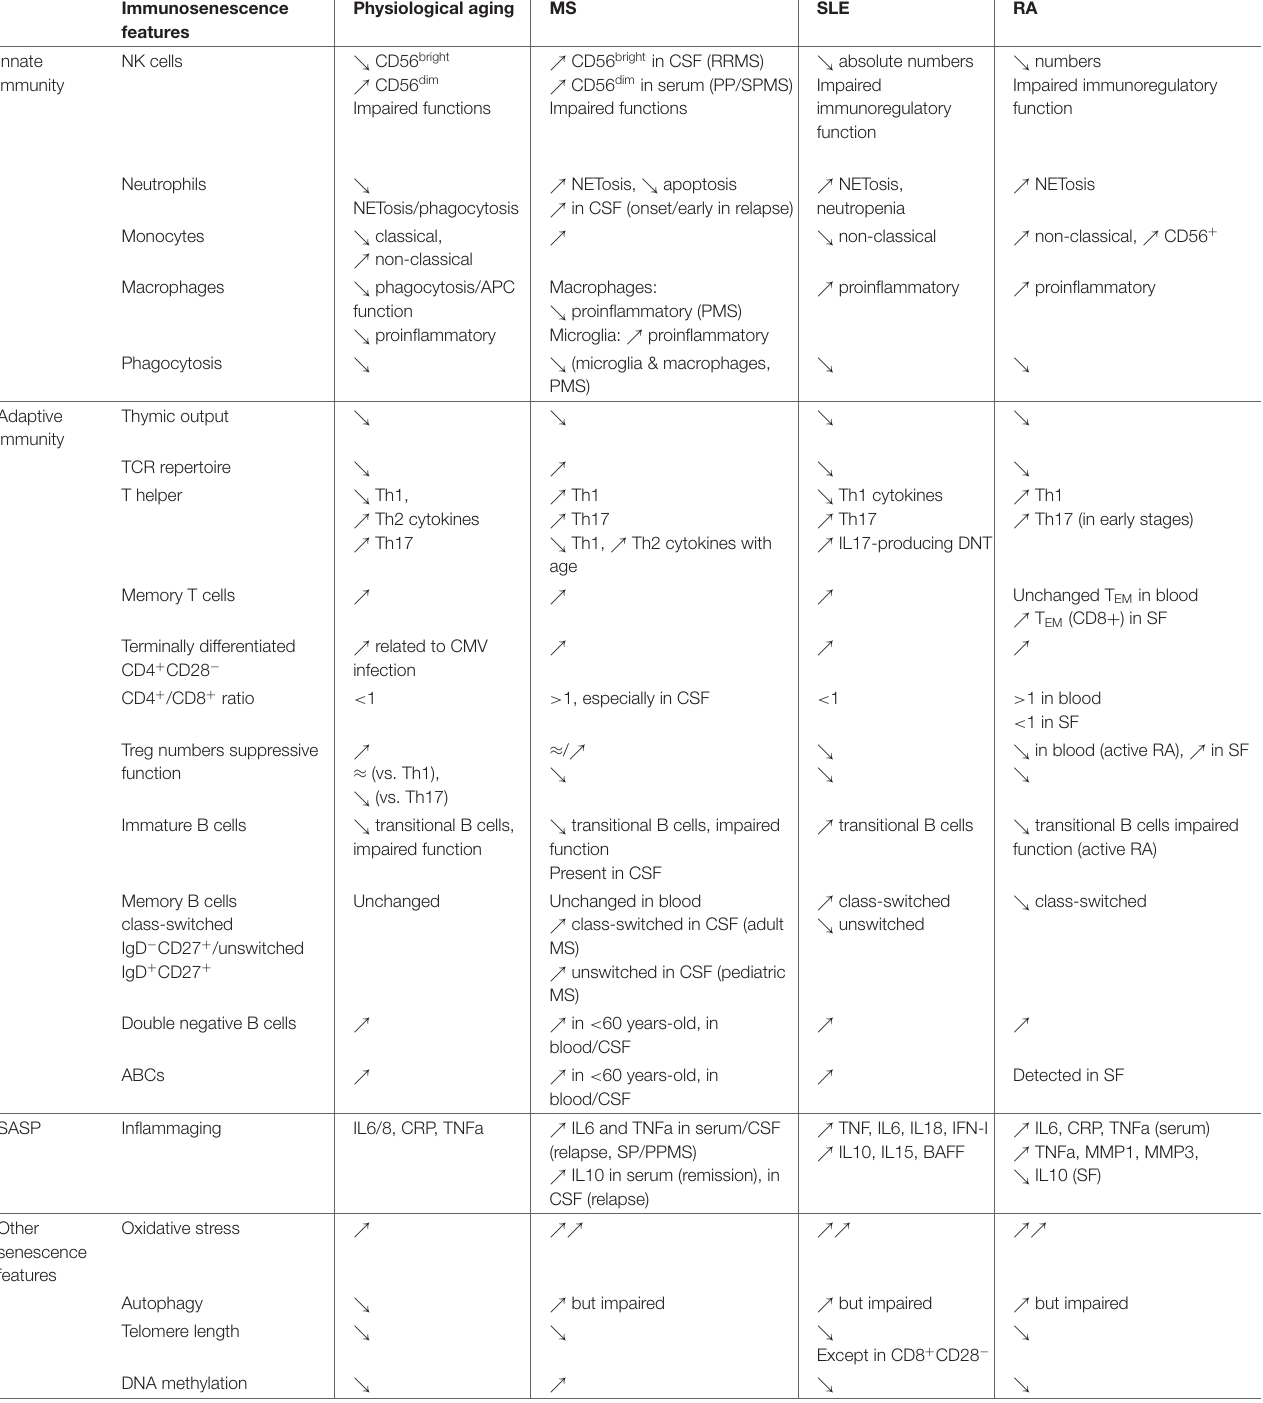
TABLE 1 | Comparison between immunosenescence features in aging, SLE, RA, and